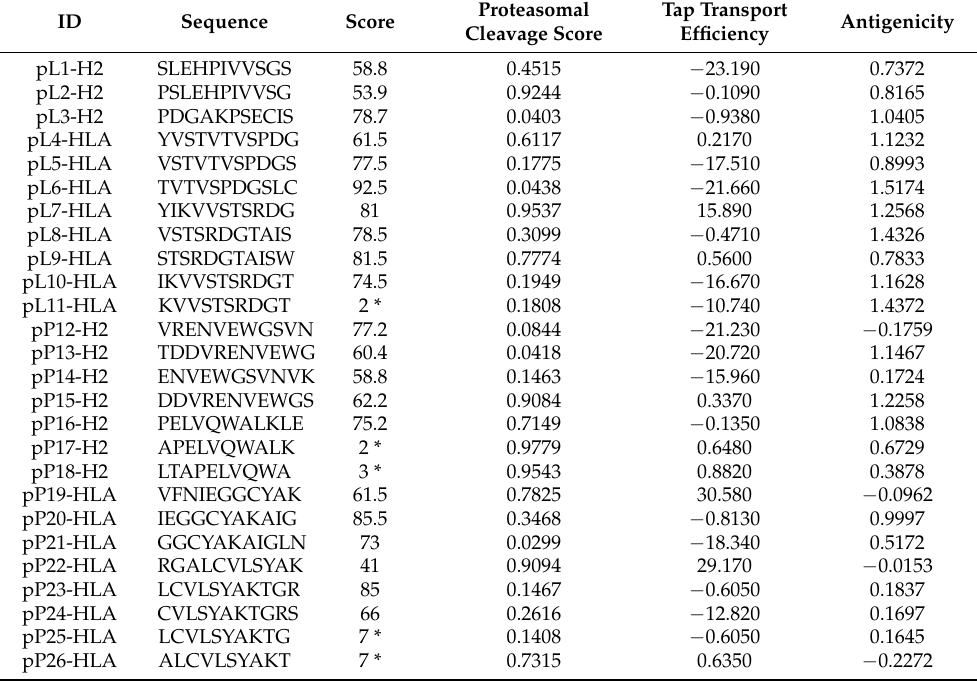
Table 1. T-cell epitope prediction of LACK and